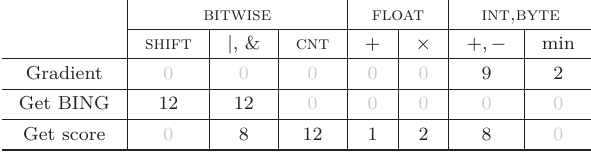
Average number of atomic operations for computing objectness of each image window at different stages: calculate normed gradients, extract BING features, and get objectness score